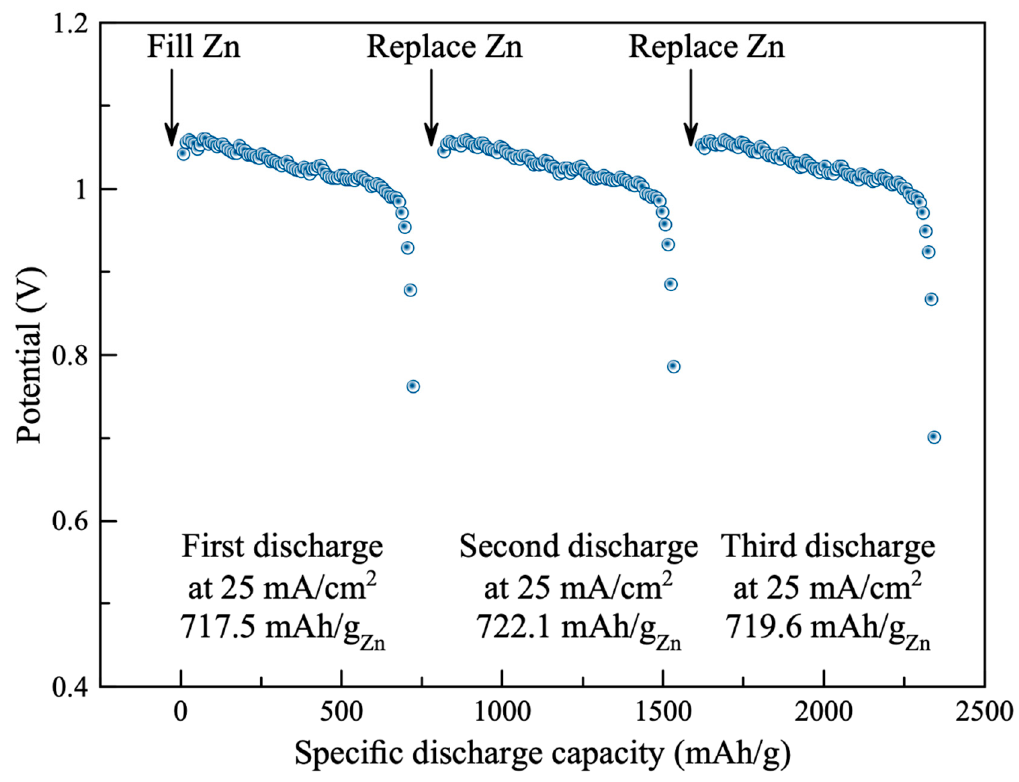
Figure 6. Stability and discharge capacity of the battery that used the synthesized catalyst (0.3 M AgNP/rGO).